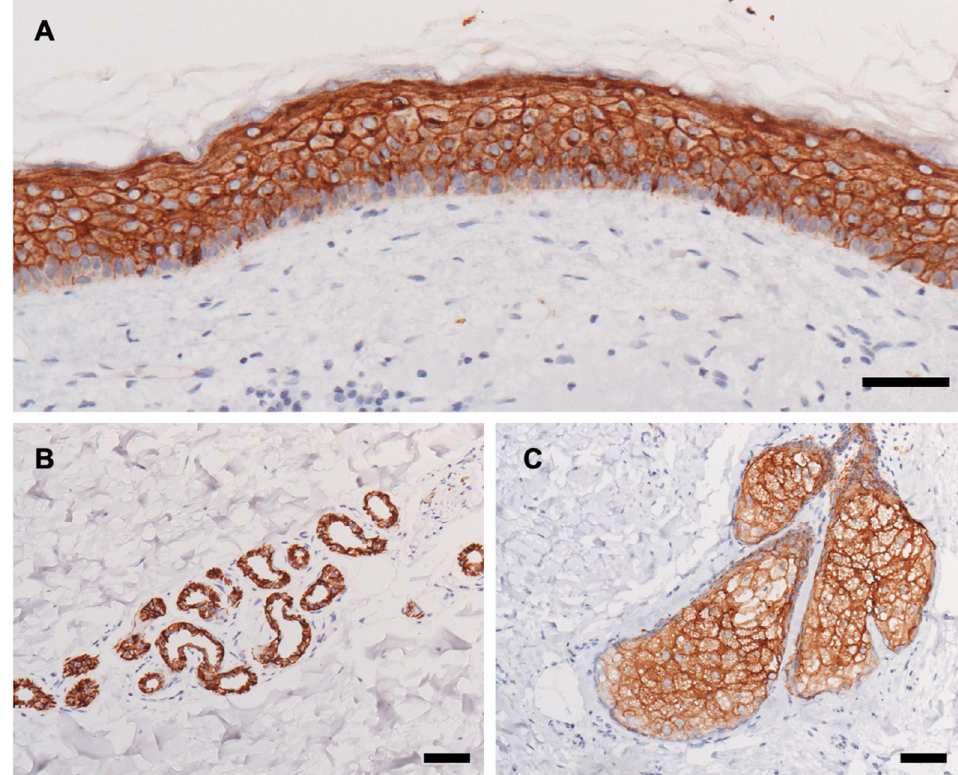
Figure 1. ( A – C ) Representative histopathological images of trophoblast cell surface antigen 2 (TROP2) staining in normal skin and skin appendages. ( A ) Epidermis. ( B ) Eccrine gland. ( C ) Sebaceous gland. Bars indicate 100 μ m.